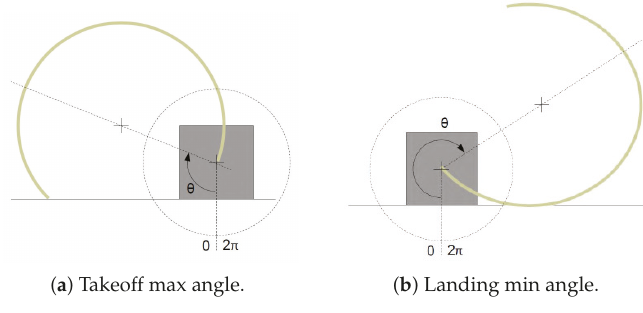
Figure 8. Limit angles for aerial movements.